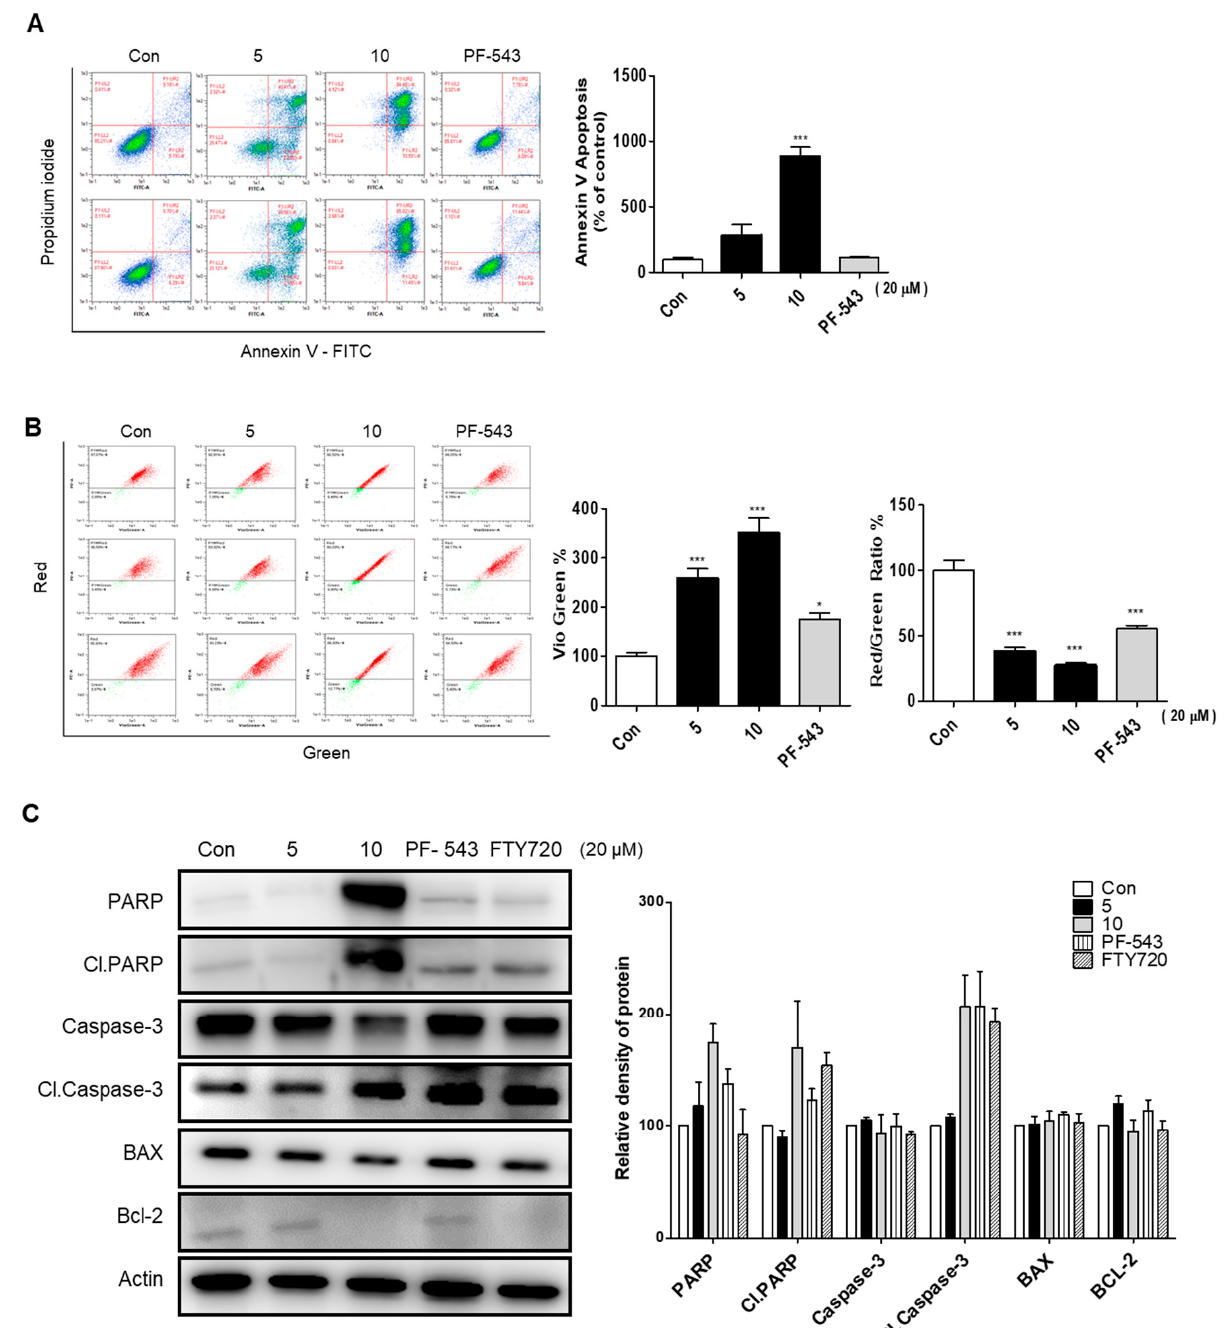
Figure 4. ( A ) MIA PaCa2 cell apoptosis effect was analyzed by annexin-V assay after treatment compounds 5 , 10 , and PF-543 (20 µ M) using flow cytometry. ( B ) Compounds 5 , 10 , and PF-543 (20 µ M) were treated in the MIA PaCa2 cell to measure JC-10 staining. ( C ) MIA PaCa2 cells were treated with compounds 5 , 10 , PF-543, and FTY720 (20 µ M) for 24 h, and the expression of PARP, Cl.PARP, Caspase-3, Cl.Caspase-3, BAX, Bcl-2; Apoptosis markers. Actin was used as a control. The experi- ments were carried out in triplicates and expressed as mean ± SD, one-way ANOVA, Turkey’s test. The values were considered significant at * p < 0.05 and *** p < 0.001.